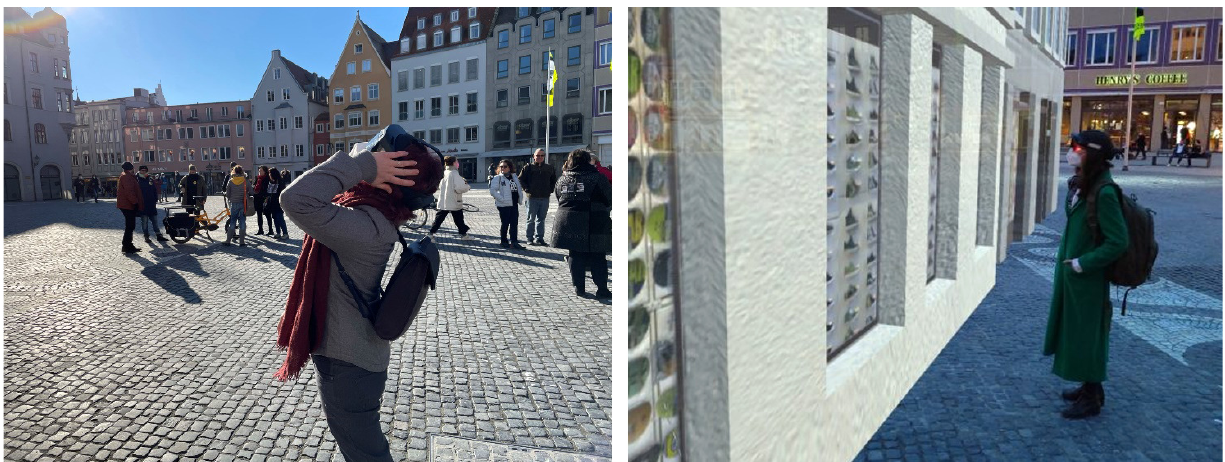
Figure 1. Test subjects wearing AR glasses on an augmented city